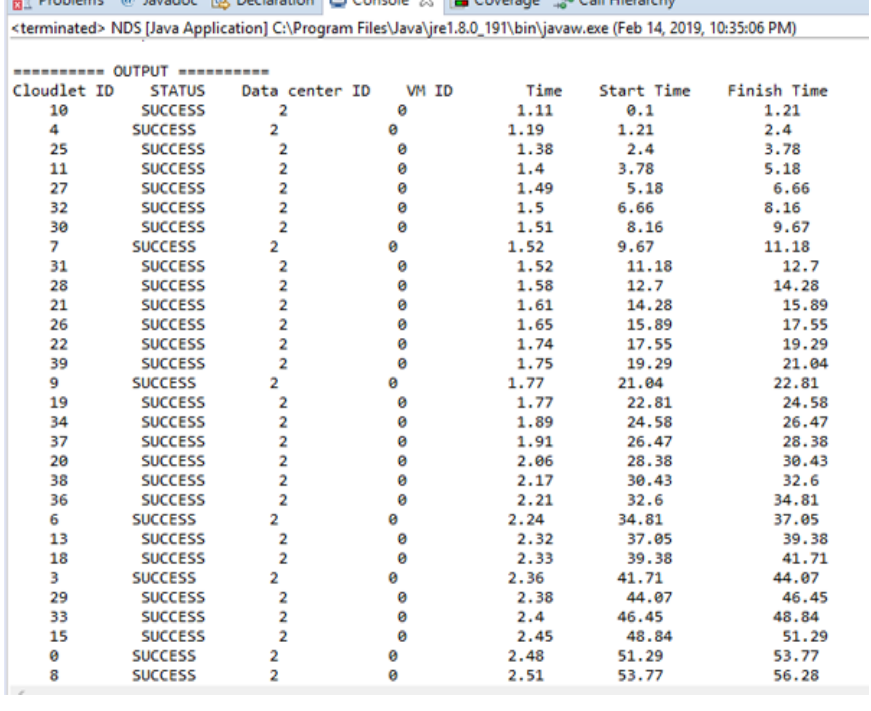
Figure 7. Experimental results in term of execution time for scheduling safety